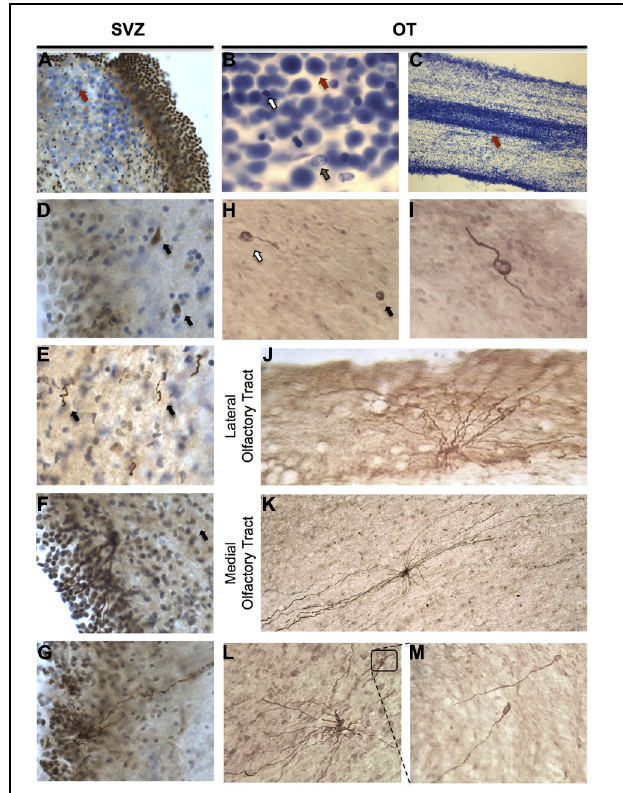
FIGURE 2 | Cellular composition and characterization of DCX-immunoreactive (IR) cells in the human olfactory tract (OT) and SVZ. (A–C) Large, densely packed cells of unknown identity were identifiable in SVZ and OT regions and formed a corridor suggestive of a rostral migratory stream. When stained with cresyl violet, these cells (red arrows) were readily distinguishable from both glia (white arrow) and neurons (brown arrow). (D–G) DCX-IR expressing cells in the human SVZ displayed variable morphologies including: neuroblast-like cells lacking processes (arrows in D ); DCX-IR cells with leading and/or trailing processes possessing a rostrocaudal orientation (arrows in E ); and multipolar cells possessing multiple processes that extended toward the ventricular surface and, occasionally, a additional basal process which projected in the opposite direction. (H,I) In the OT, DCX-IR somata with (white arrow) and without (black arrow) processes were observed, as were DCX-IR bipolar cells. (J,K) DCX-IR multipolar cells were present in both lateral and medial regions. DCX-IR processes were generally aligned parallel to the tract, particularly in medial OT regions. (L,M) Occasionally, DCX-IR multipolar cells possessed bulbous, growth cone-like